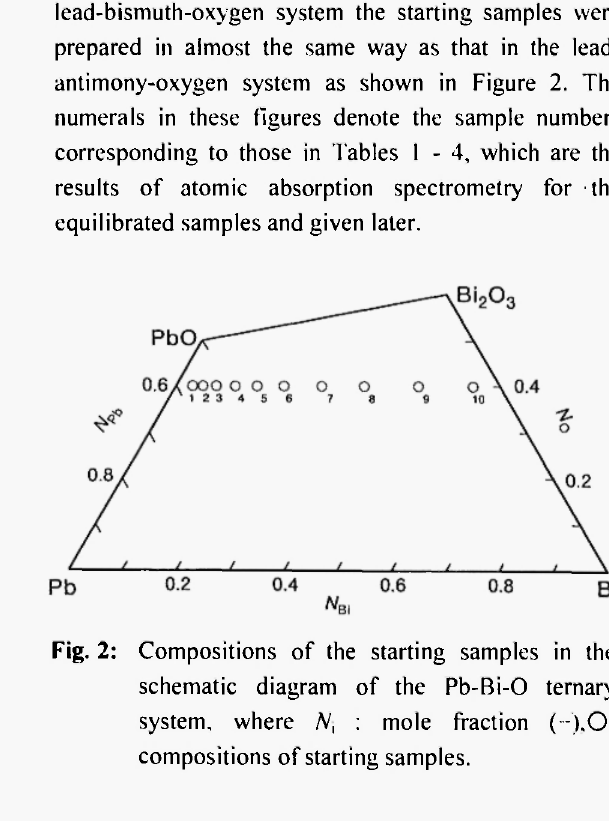
Fig. 2: Compositions of the starting samples in the schematic diagram of the Pb-Bi-0 ternary system, where /V, : mole fraction ( ).0: compositions of starting